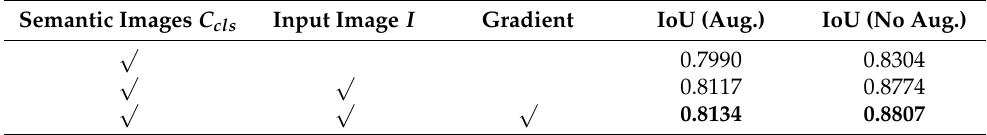
Table 5. Performance comparison of different discriminator